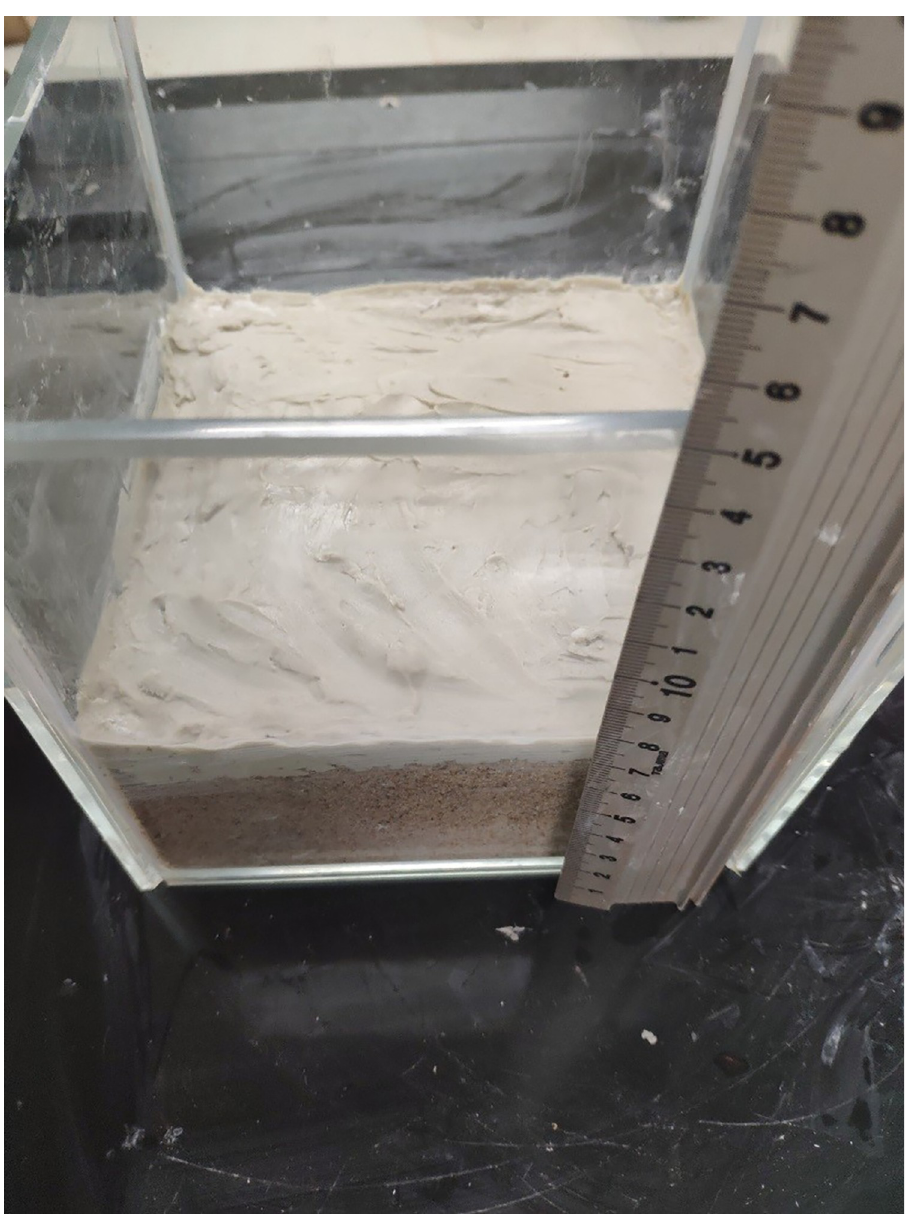
Fig 21. 11 mm bentonite film.